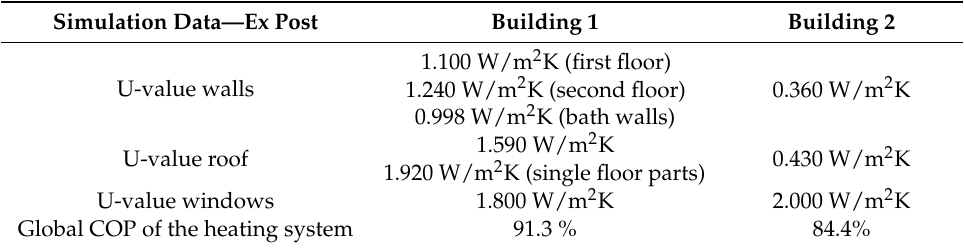
Table 7. Buildings’ model data set post